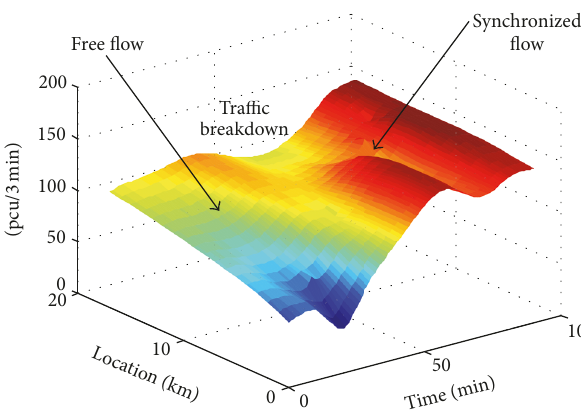
Figure 8: Temporal-spatial distribution of traffic flow at freeway work